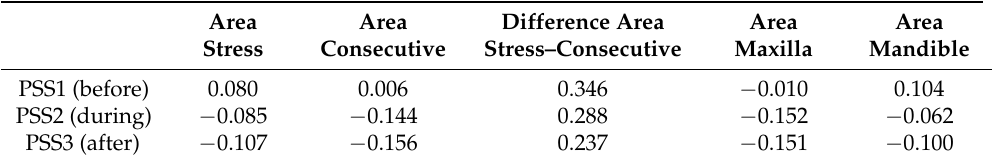
Table 3. Spearman correlations between Perceived Stress Scale (PSS-10) scores and attrition areas (all p > 0.05); PSS1: assessment before application of BruxChecker ® , PSS2: during the wear phase of BruxChecker ® , PSS3: at the end of the wear phase of BruxChecker ® . Area Area Difference Area Area Area Stress Consecutive Stress–Consecutive Maxilla Mandible − 0.010 0.104 0.346 0.006 0.080 PSS1 (before) − 0.062 − 0.152 − 0.144 − 0.085 0.288 PSS2 (during) − 0.100 − 0.151 − 0.156 − 0.107 0.237 PSS3 (after) PSS (1,2,3), Perceived Stress Scale (PSS-10). The correlation between attrition areas (“stress”, “consecutive”, difference “stress”– “consecutive”, maxilla, mandible) and SVF was significant regarding the difference stress- consecutive and trivialization (r = 0.392, p < 0.05) and reaction control (r = 0.421, p < 0.05), escape (r = 0.385, p < 0.05), perseveration (r = 0.473, p < 0.05; Figure 4), and self-blame (r = 0.419, p < 0.05) as well as regarding need for social support, showing a significant inverse correlation with area on consecutive days (r = − 0.389, p < 0.05) and mandibular attrition area (r = − 0.469, p < 0.05) (Table 4). Table 4. Spearman correlations between scores of the coping questionnaire (SVF) and attrition areas. Significant ( p < 0.05) correlations indicated by (*). Area Area Difference Area Area Area Stress Consecutive Stress–Consecutive Maxilla Mandible BAG 0.288 0.202 0.392 * 0.306 0.155 HER − 0.066 − 0.115 0.237 − 0.115 − 0.056 SCHAB 0.100 0.075 0.116 0.103 0.064 ABL − 0.160 − 0.149 − 0.045 − 0.147 − 0.153 ERS − 0.107 − 0.156 0.238 − 0.123 − 0.134 SEBEST − 0.126 − 0.117 − 0.036 − 0.104 − 0.134 ENTSP 0.150 0.116 0.154 0.205 0.038 SITKON − 0.051 − 0.084 0.160 − 0.084 − 0.045 REKON 0.090 0.000 0.421 * − 0.001 0.096 POSI − 0.057 − 0.132 0.359 − 0.140 − 0.035 BESOZU − 0.354 − 0.389 * 0.185 − 0.271 − 0.469 * VERM − 0.239 − 0.305 0.326 − 0.210 − 0.329 FLU 0.173 0.090 0.385 * 0.154 0.095 SOZA 0.062 0.000 0.292 0.077 − 0.027 GEDW 0.166 0.064 0.473 * 0.165 0.047 RES 0.136 0.067 0.320 0.180 0.000 SEMITL 0.310 0.238 0.322 0.323 0.197 SESCH 0.292 0.200 0.419 * 0.315 0.147 AGG 0.107 0.073 0.156 0.096 0.077 PHA 0.068 − 0.001 0.324 0.041